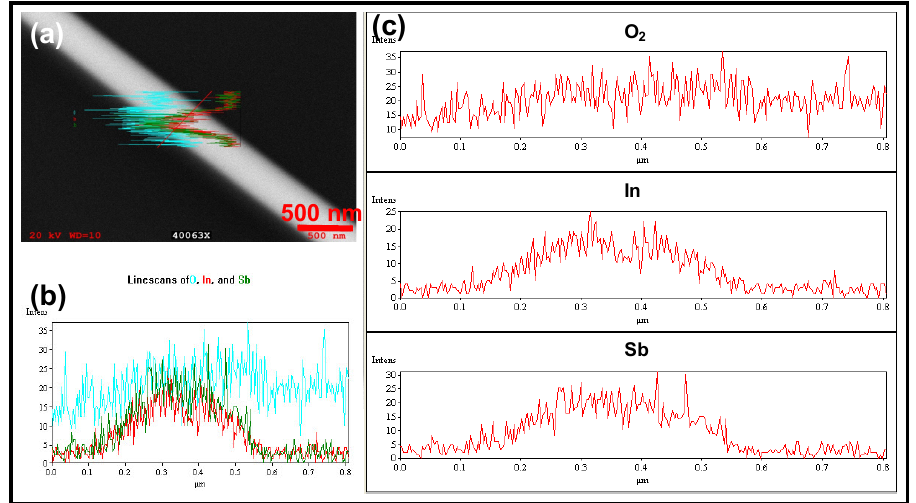
Figure 1. EDX spectrum showing composition mapping of a single InSb NW: ( a ) Intensity maps for In (red), Sb (green) and O 2 (cyan) mapped across the width of the NW; ( b ) Intensity mapping of the three elements (O 2 , In and Sb ) shown independently for comparison; ( c ) Superimposed elemental maps showing the NW is pure InSb . The relatively flat O 2 EDX signal shows no characteristic feature corresponding to the NW and its origin is form the underlying SiO 2 layer